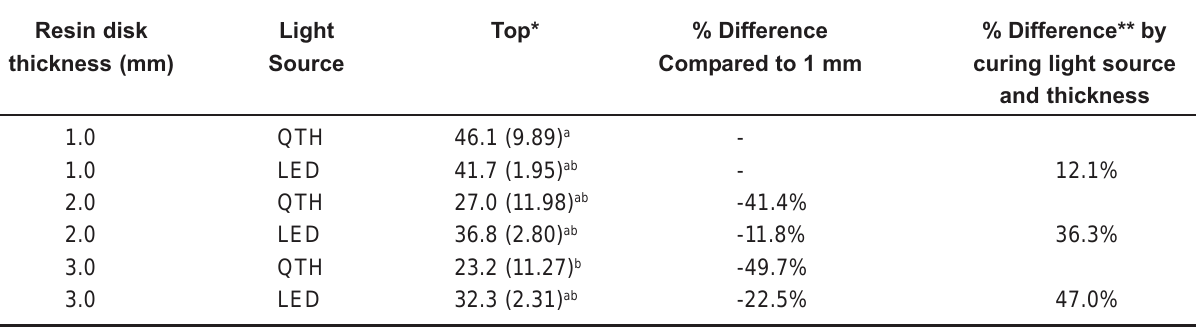
*Same superscripted letters indicate no statistically significant differences (p >